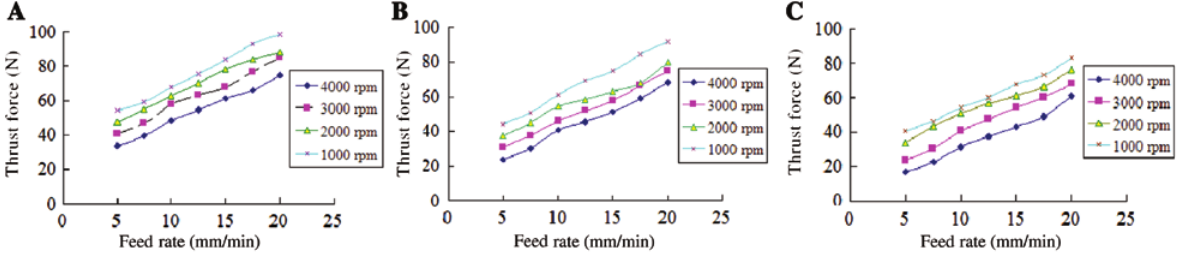
Figure 7: The typical relationship of thrust force with the three different drills. (A) Carbide drill, (B) DLC drill, and (C) PCD drill.